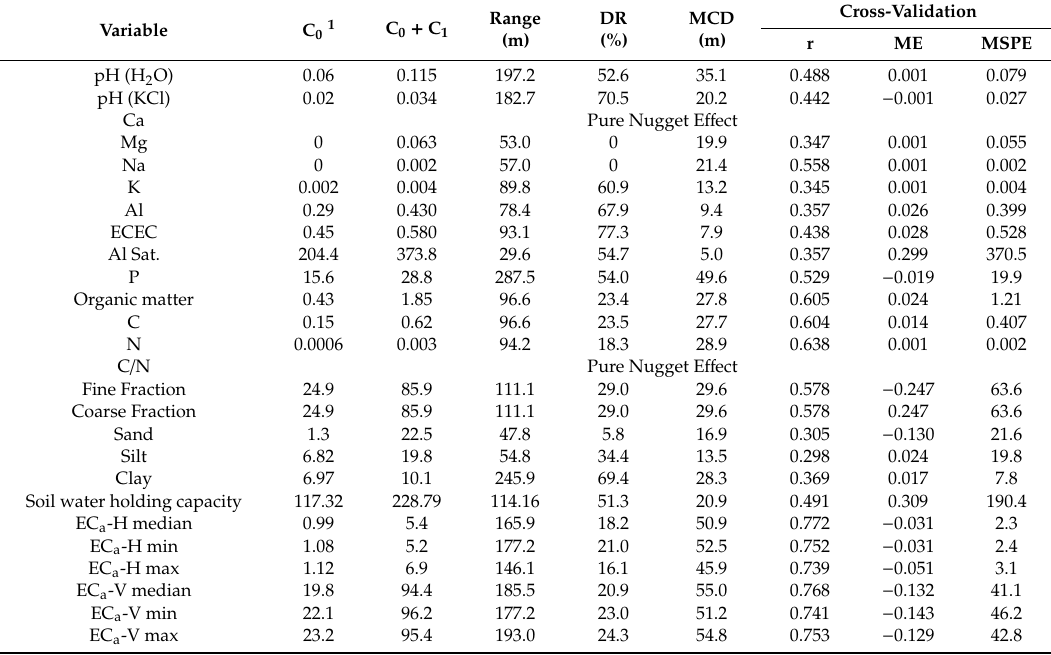
Table 2. Theoretical model parameters fitted to experimental semivariograms of the studied soil properties. All the fitted models corresponded to spherical structures. Cross-validation indicators are also